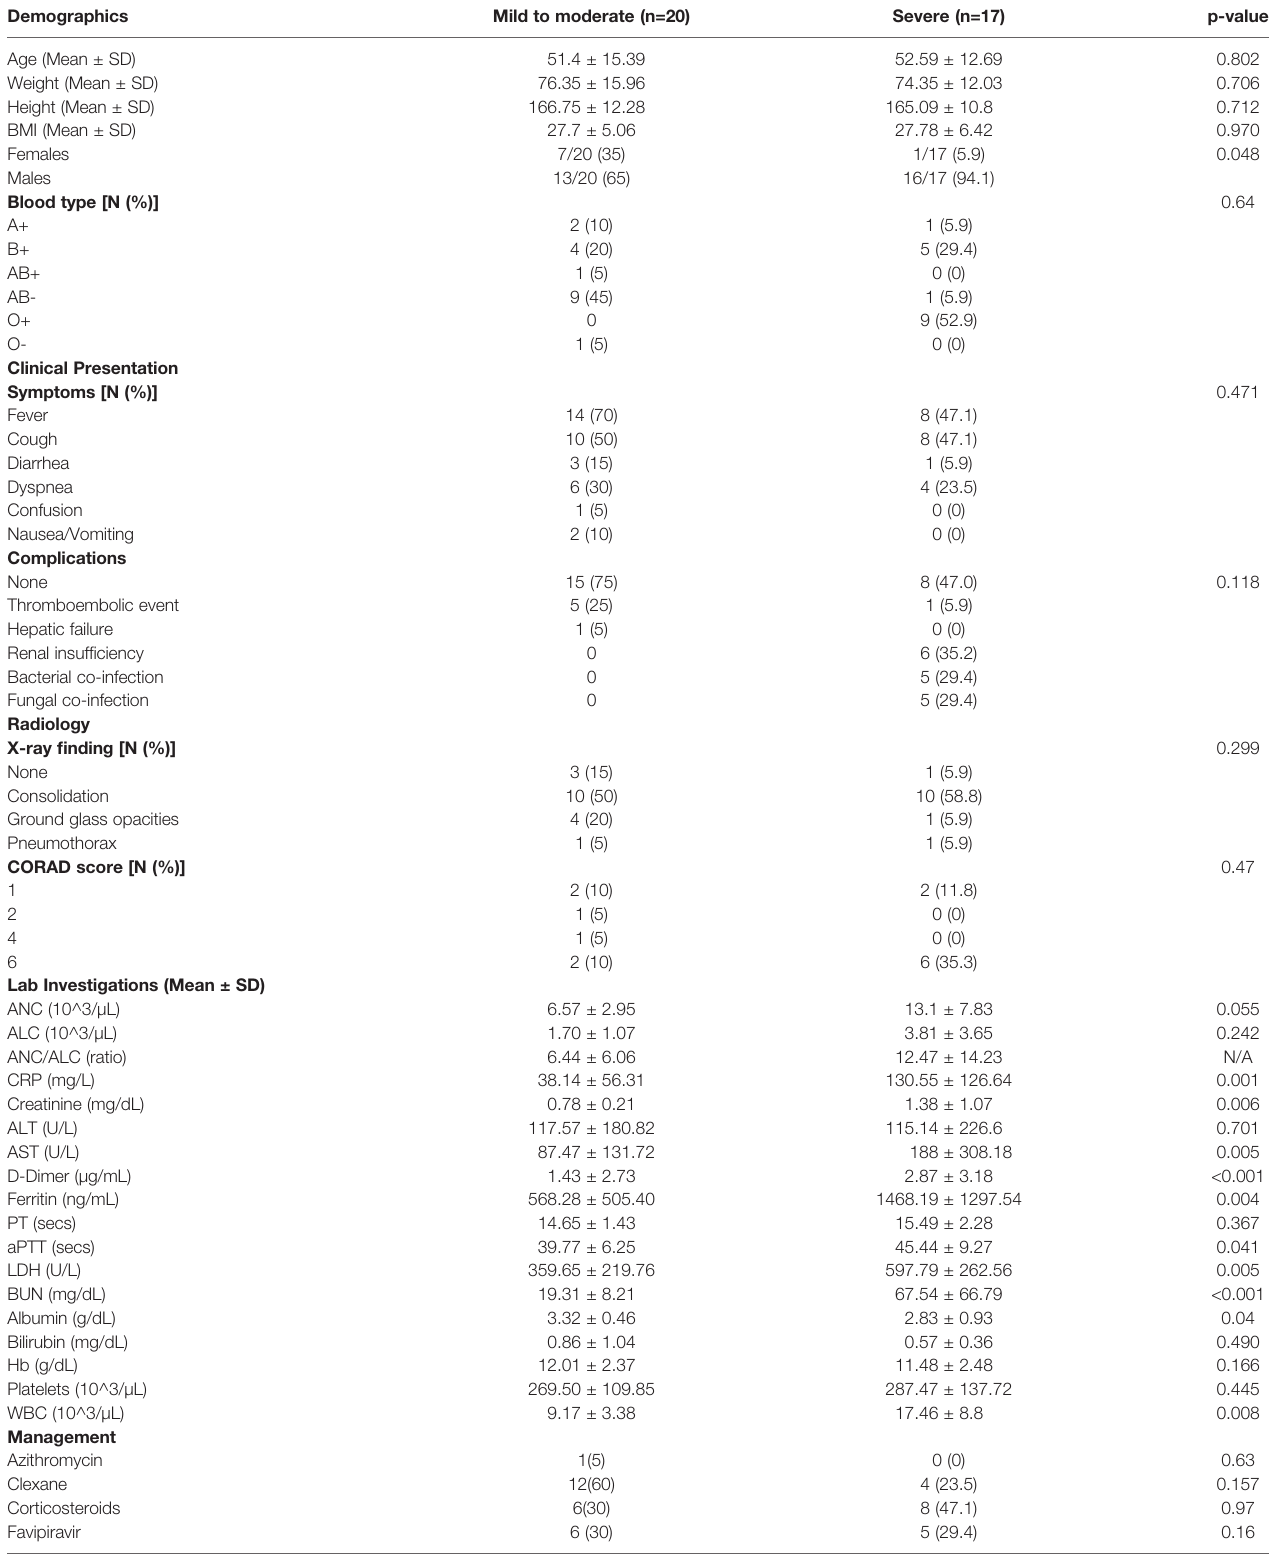
TABLE 2 | Demographic, Clinical and laboratory data of the validation cohort (COVID-19 patients tested for